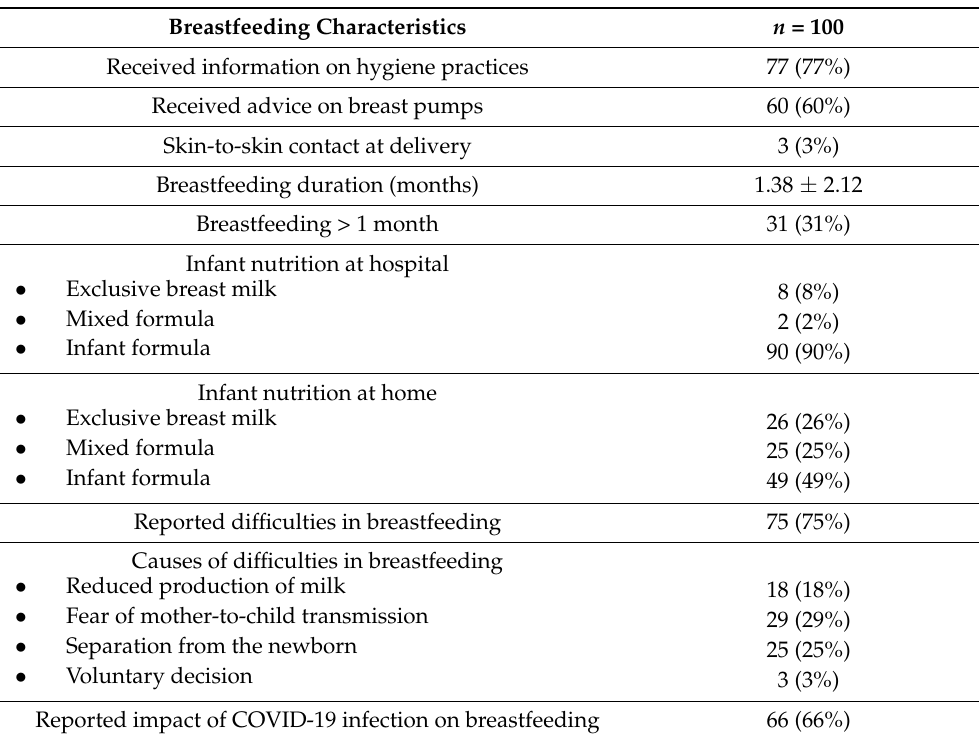
Table 2. Breastfeeding characteristics of COVID-19 infected women. Breastfeeding